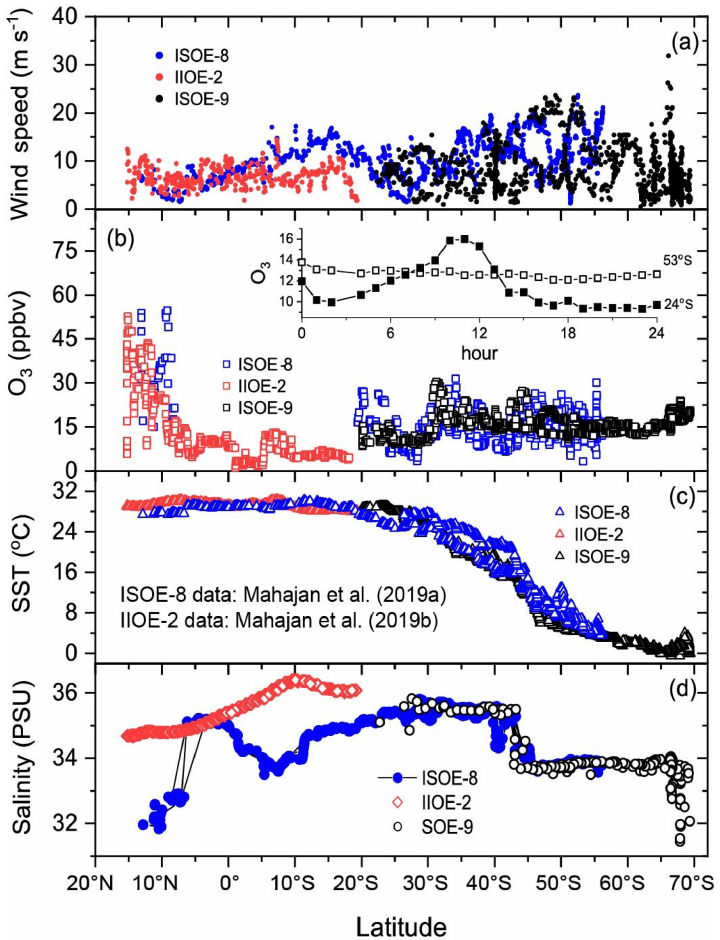
Figure 5. Latitudinal plot of hourly averaged field measurements of wind speed, ozone mixing ratios, SST, and salinity (salinity data for IIOE-2 are monthly climatological means from the World Ocean Atlas as described in the Supplement) from the ISOE-8, IIOE-2, and ISOE-9 campaigns. Data markers in red are for the IIOE-2 campaign; those in blue are for ISOE-8, and markers in black are from ISOE-9 for all the panels. Observational plots for ISOE-8 and IIOE-2 were adapted from Mahajan et al. (2019a,